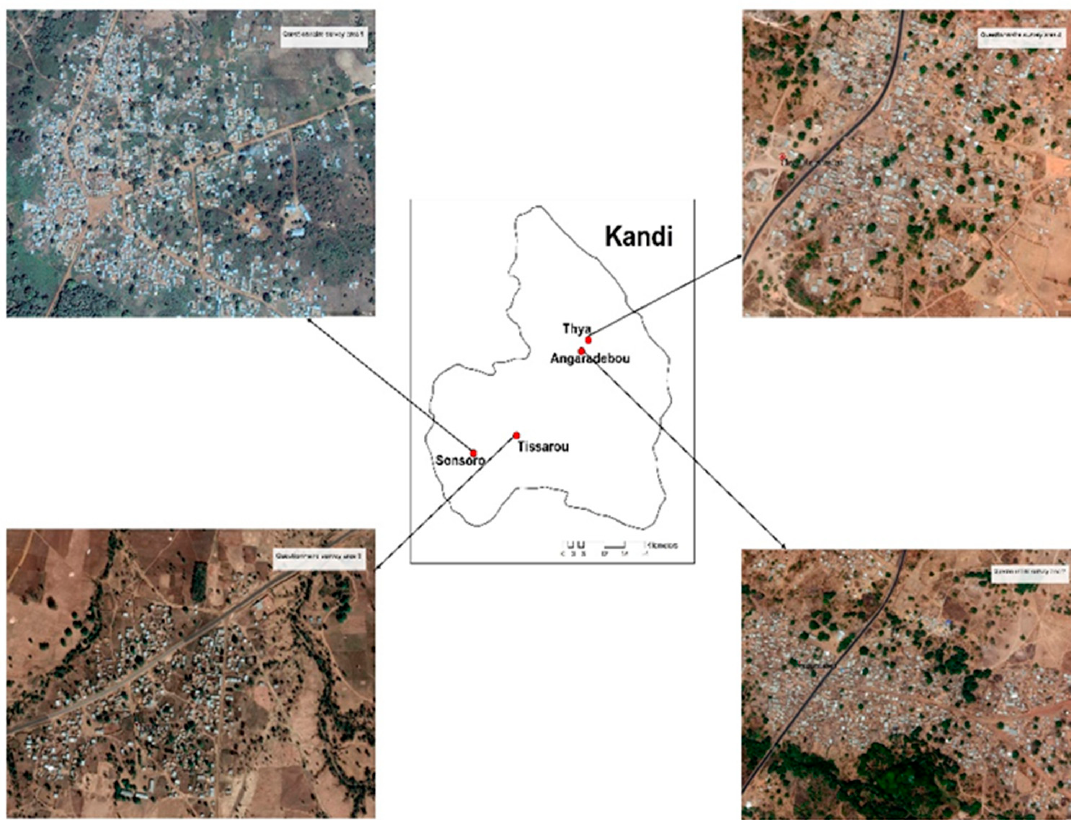
Figure 3. Location of survey farmers.